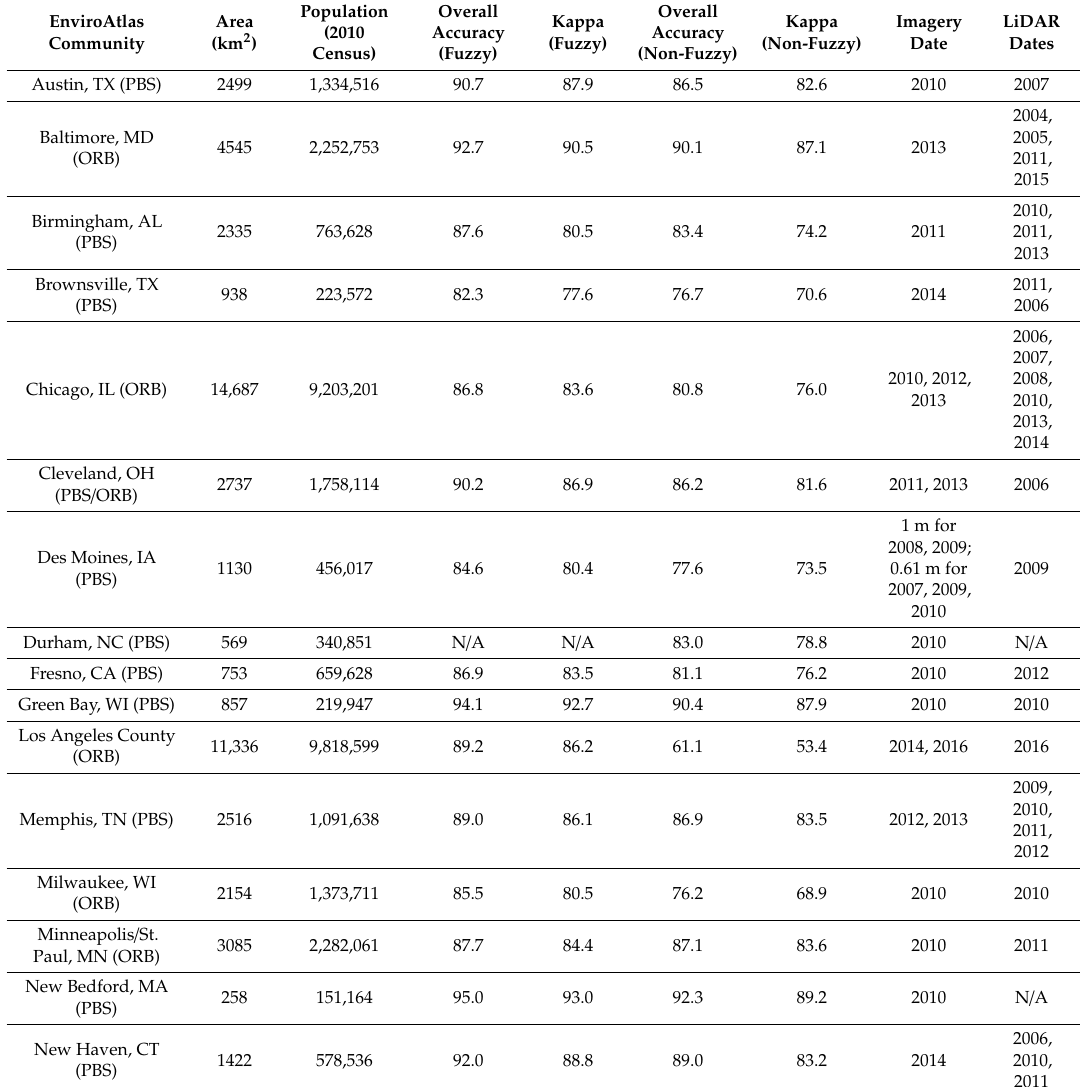
Table 3. MULC statistics for EnviroAtlas communities. Abbreviations after the community name indicate the main method used in classification: pixel-based supervised (PBS), object-based supervised (OBS), or object rule-based